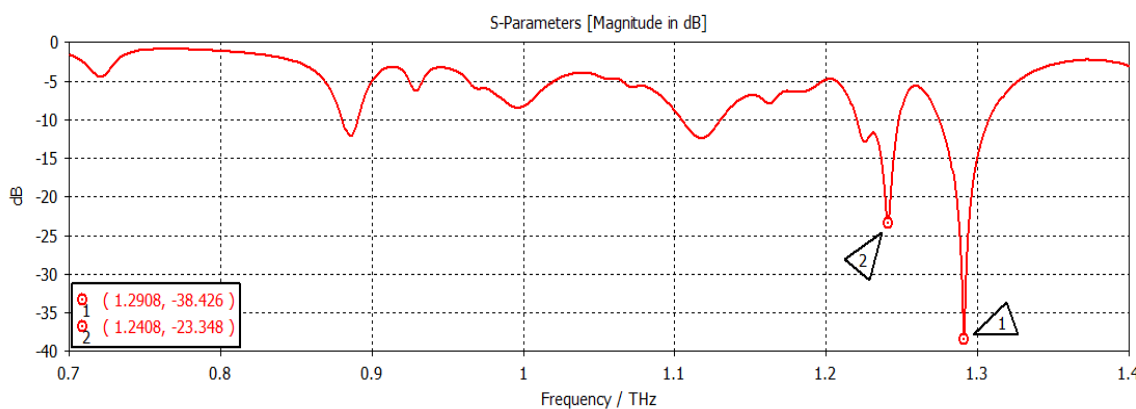
Figure 14. w 1 = 150 µm and z 1 = 100 µm.